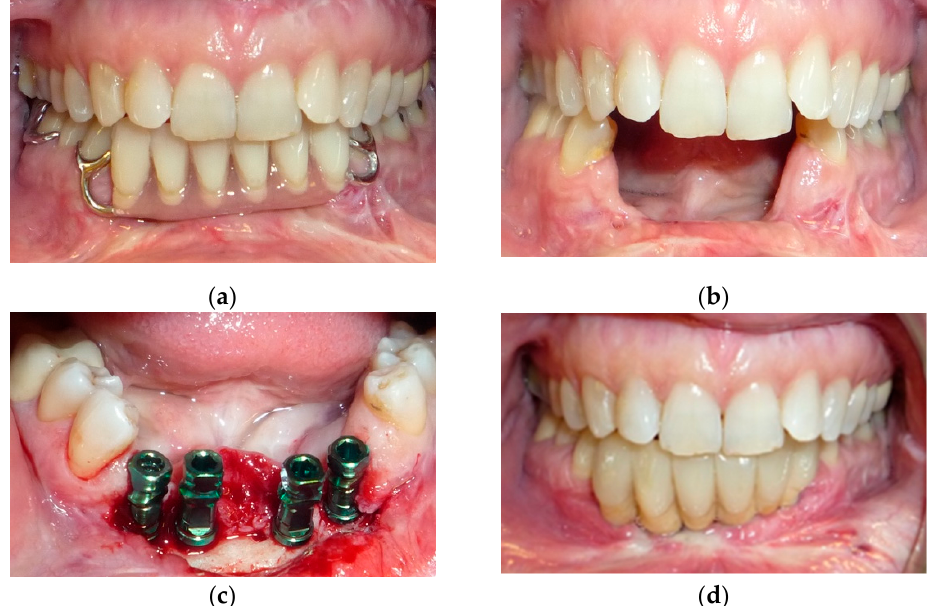
Figure 3. Intraoral view: ( a ) temporary resin removable prosthesis; ( b ) after a fornix depth surgery; ( c) implant surgery; ( d ) final implant-retained prosthesis.